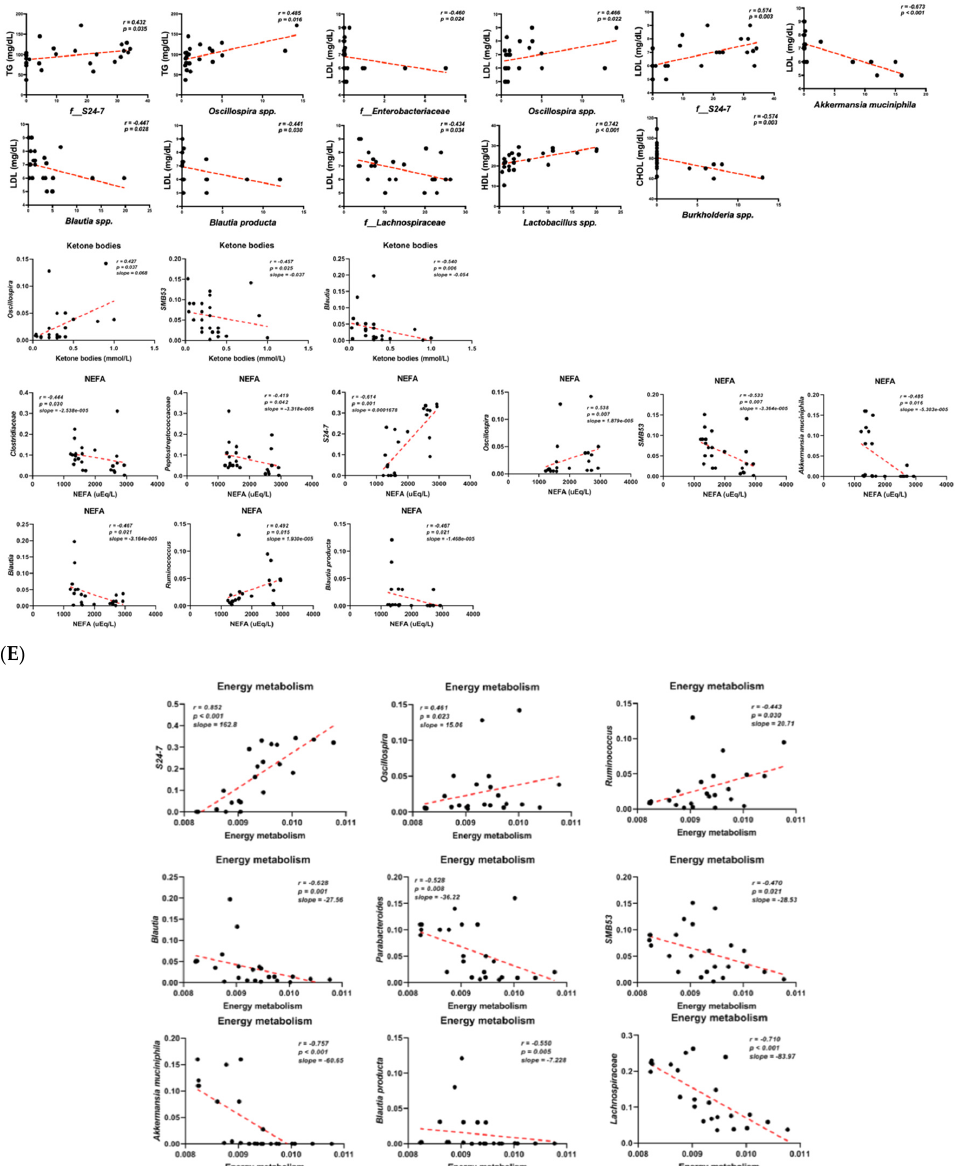
Figure 6. Functional pathways modulated by gut microbiota and association. A total of nine key functional pathways were found to be associated with the probiotic treatments. ( A ) Venn plot of functional pathways affected by changes in gut microbiota. ( B ) Bar graph showing the nine functional pathways responsive to the probiotic treatments. ( C ) Spearman’s correlation heatmap displayed the relationship of blood biochemistry with energy metabolism and retinol metabolism. Scatter plots displayed the energy metabolism was positively correlated with NEFA, ketone bodies, TG, and LDL. Retinol metabolism was negatively correlated with CHOL and LDL. ( D ) Spearman’s correlation heatmap displaying the relationship of blood biochemistry with gut microbiota. Scatter plots displaying that ketone bodies were positively correlated with Oscillospira and negatively correlated with SMB53 and Blautia . NEFAs were positively correlated with Oscillospira , S24-7 , and Ruminococcus , and negatively correlated with SMB53, Blautia , Clostridaceae, Peptostreptococcaceae , and A. muciniphila . ( E ) Scatter plots displaying that energy metabolism was positively correlated with S24-7 , Oscillospira , and Ruminococcus . In constant, it was negatively correlated with Lachnospiraceae , SMB53 , Blautia , Parabacteroides , and A. muciniphila . Statistical analyses were performed by using the Student’s t- test. Statistical difference is shown as comparison between the CH and probiotics-treated groups ( # p < 0.05, ## p < 0.01; * p < 0.05, ** p < 0.01, *** p <